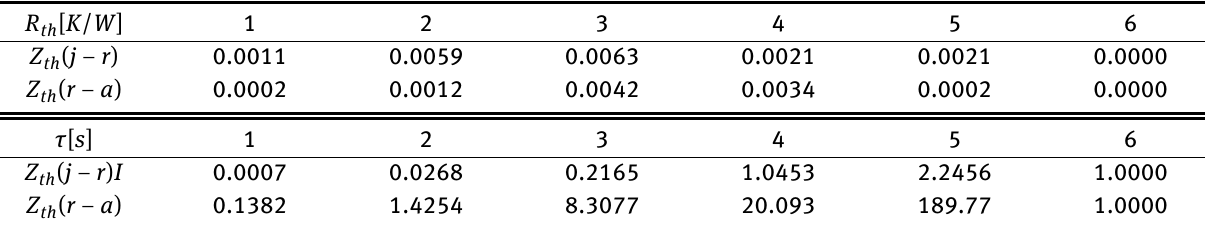
Table 5: Thermal Impedance of Cauer Network R th [ K / W ] 1 2 3 Z th ( j − r )